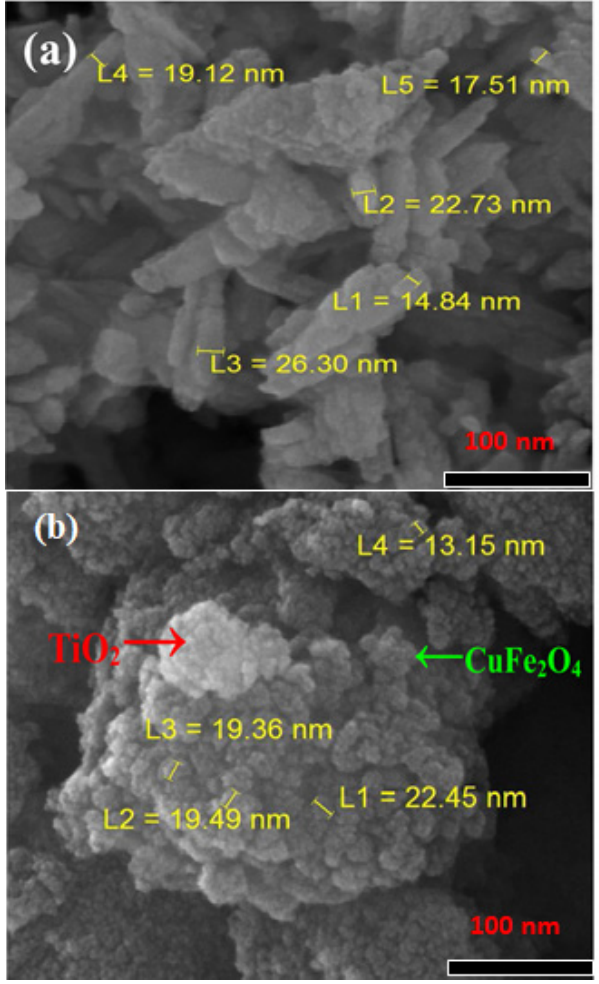
Figure 11. SEM micrographs of: ( a ) CuFe 2 O 4 and ( b ) magnetic nanocomposite TiO 2 /CuFe 2 O 4 [109]. Republished with permission from Elsevier.